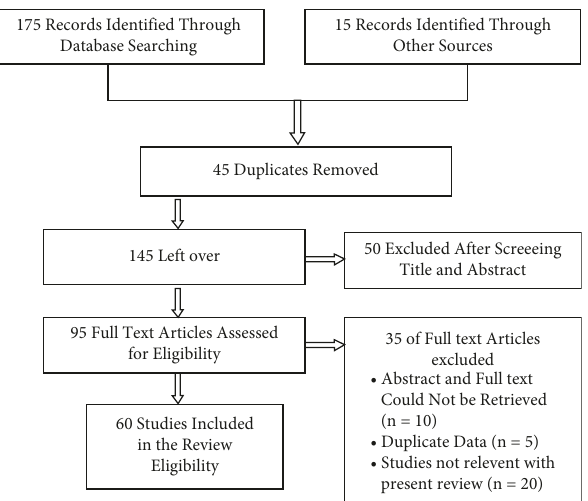
Figure 1: Flow diagram of research methodology.